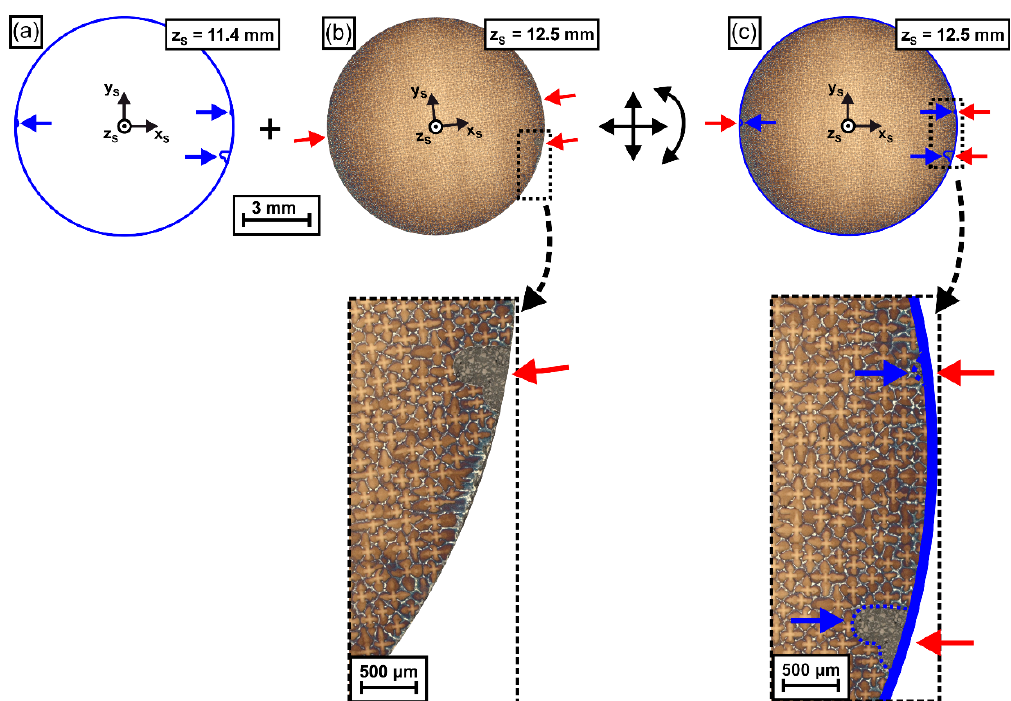
Figure 3. Generation of a digital reference mask for the registration of tomographic micrographs taken at different height positions (z S ) of the SX rod. ( a ) Sample cross section with three EDM marker notches. ( b ) Corresponding digital reference mask. The blue arrows indicate the positions of the three EDM marker notches.